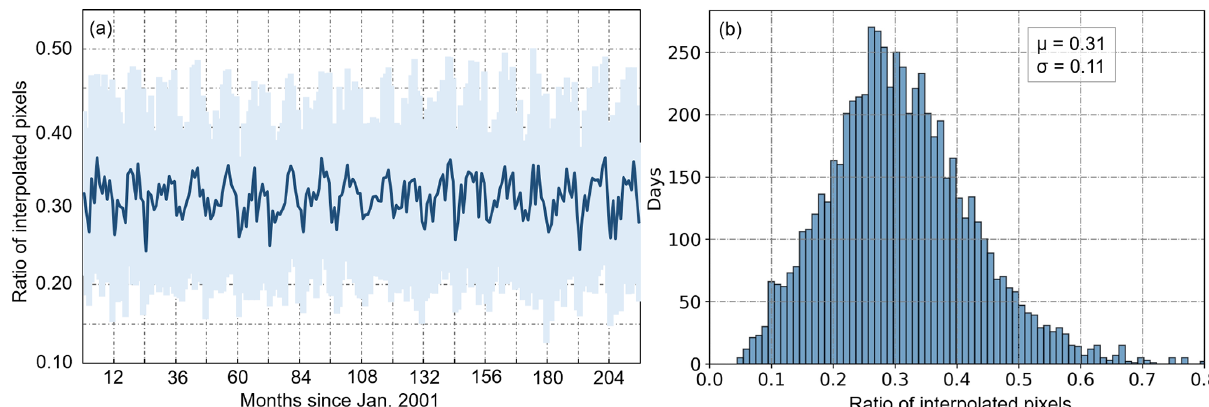
Figure B1. Ratio of interpolated pixels of land surface temperature (MOD11) data: (a) time series of interpolated pixels per month over 2001–2018 and (b) histogram of the ratio of interpolated